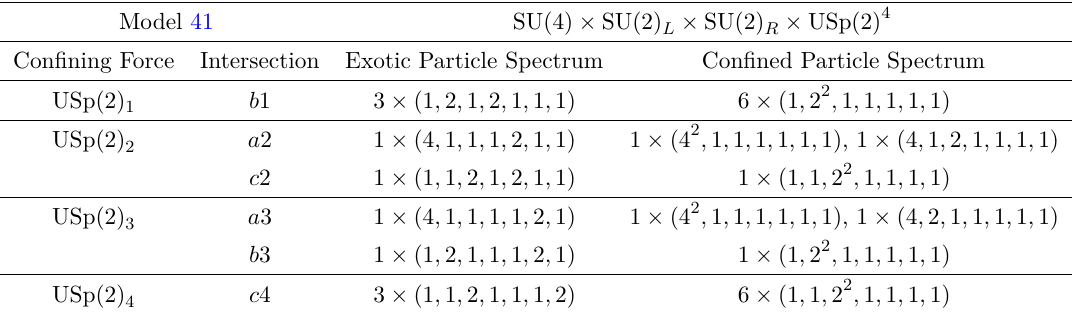
Table 4 . The composite particle spectrum of Model 41, which is formed due to the strong forces from hidden